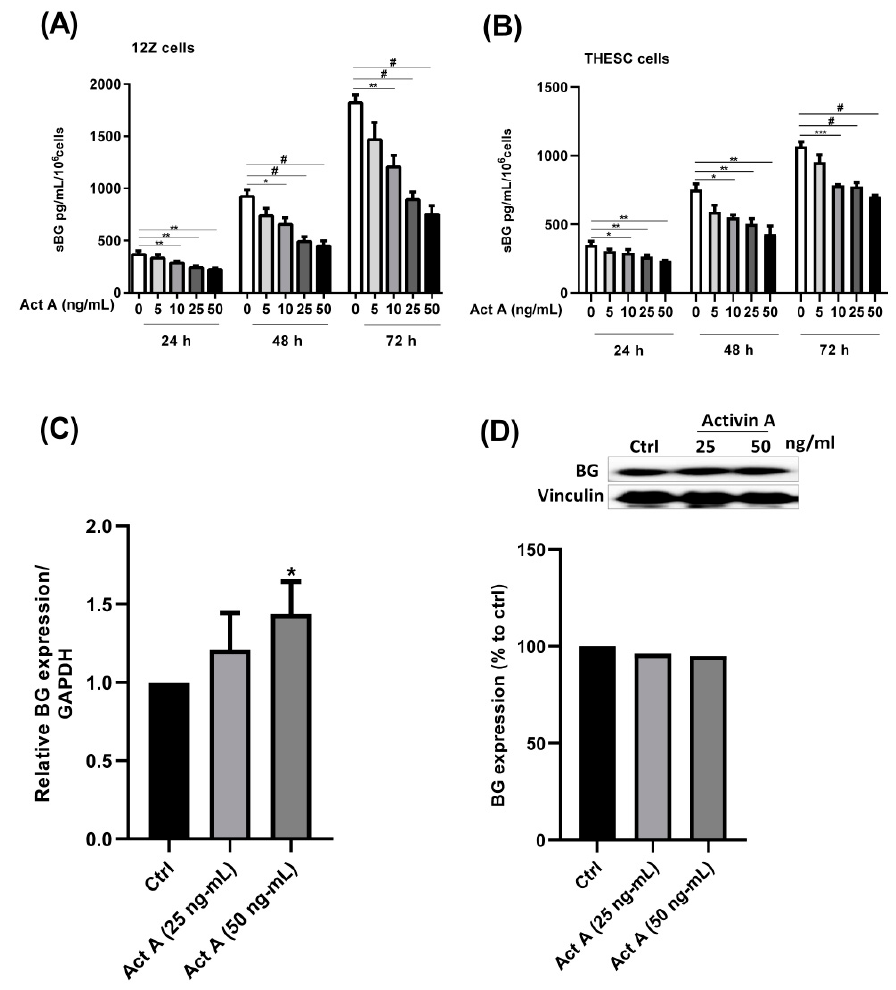
Figure 1. Time- and concentration-dependent effects of activin A on BG shedding and expression in epithelial and stromal cells. Epithelial 12Z ( A ) and stromal THESC cells ( B ) were stimulated with increasing concentrations of activin A (5–50 ng/mL) for 24, 48, and 72 h and supernatants were analyzed by sBG ELISAs. The 12Z cells were also treated with 25 and 50 ng/mL of activin A and BG mRNA ( C ) and protein expression ( D ) and were analyzed by RT-qPCR and western blot after 2 h and 24 h, respectively. Activin A treatment significantly suppressed BG shedding in a time- and concentration-dependent manner in both epithelial and stromal cells. Moreover, the activin A stimulation significantly increased BG mRNA but had no effect on the BG protein expression. Untreated cells were used as controls. Each bar represents the mean ± SEM of 3 independent experiments performed in duplicate. Dunnett’s test was used for statistical analysis; * p ≤ 0.05; ** p < 0.01; *** p < 0.001; # p < 0.0001; sBG, soluble betaglycan; Act A, activin